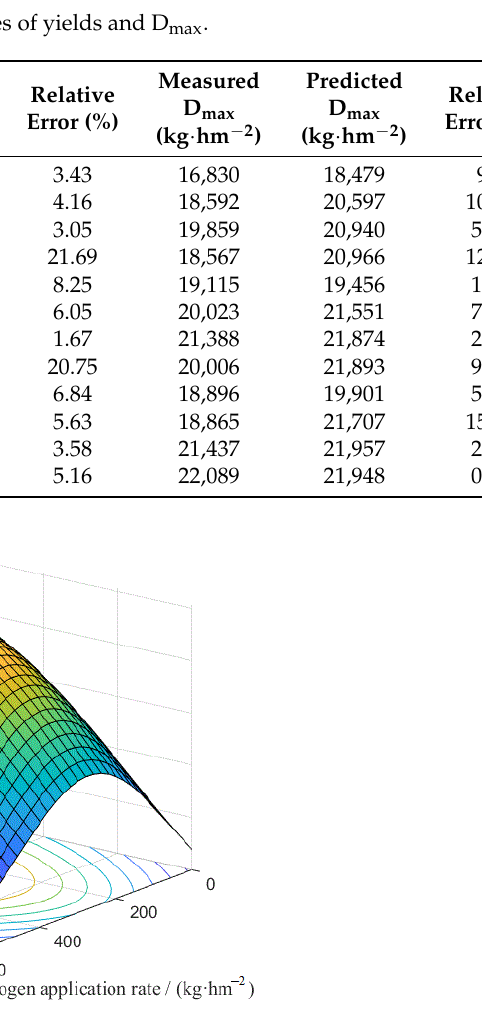
Figure 6. Prediction results for D max with Gaussian regression model for water and nitrogen cou-